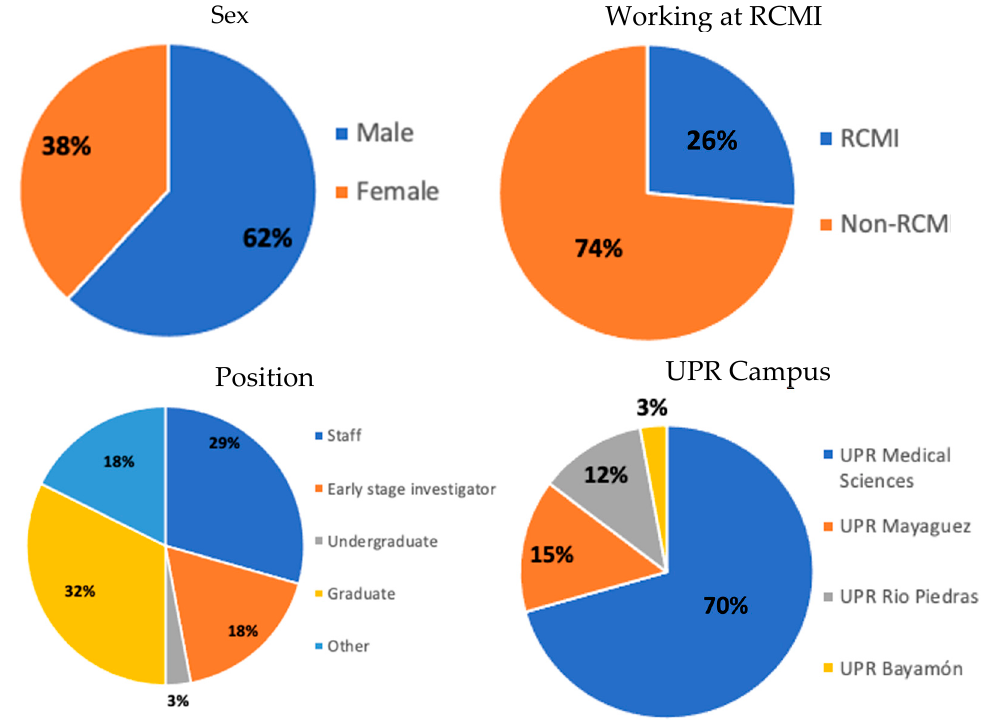
Figure 1. Course participants’ demographics and other